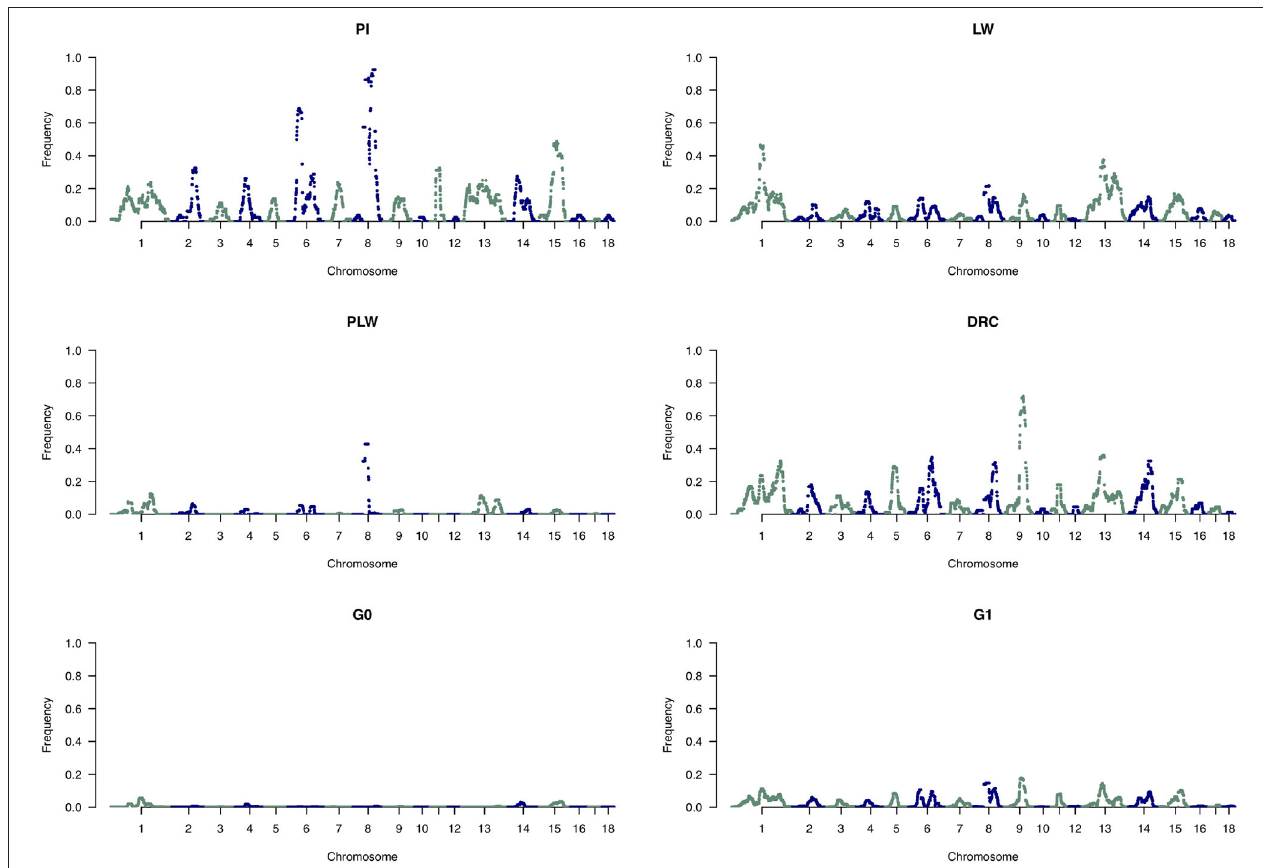
FIGURE 10 | Manhattan plots of the frequency of SNP detected inside large runs of homozygosity (ROH). DRC, Duroc; G0, (Pietrain × Large White) × Duroc offspring; G1, G0 × G0 offspring; LW, Large White; PI, Pietrain; PLW, Pietrain × Large White.